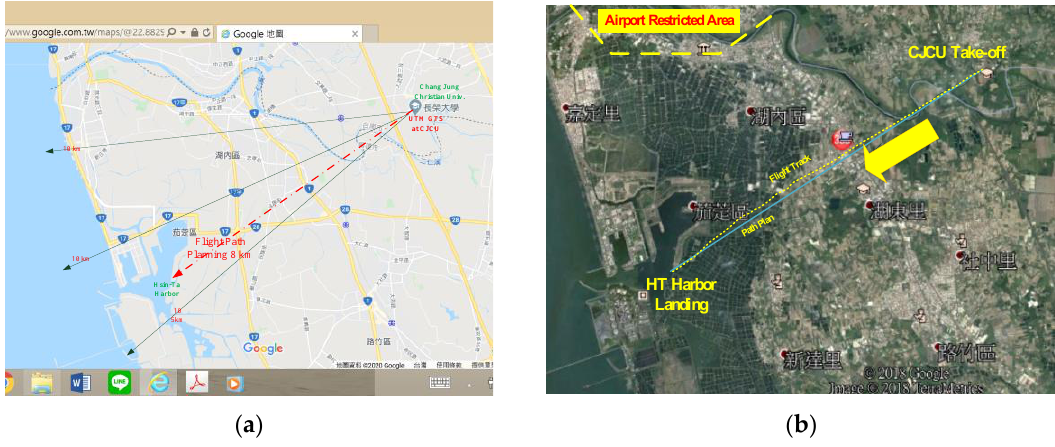
Figure 11. UAV delivery test 2 from CJCU, Queiren to Hsin-Ta Harbor under UTM ( a ) Test 2 path planning; ( b ) Test 2 UTM tracking .